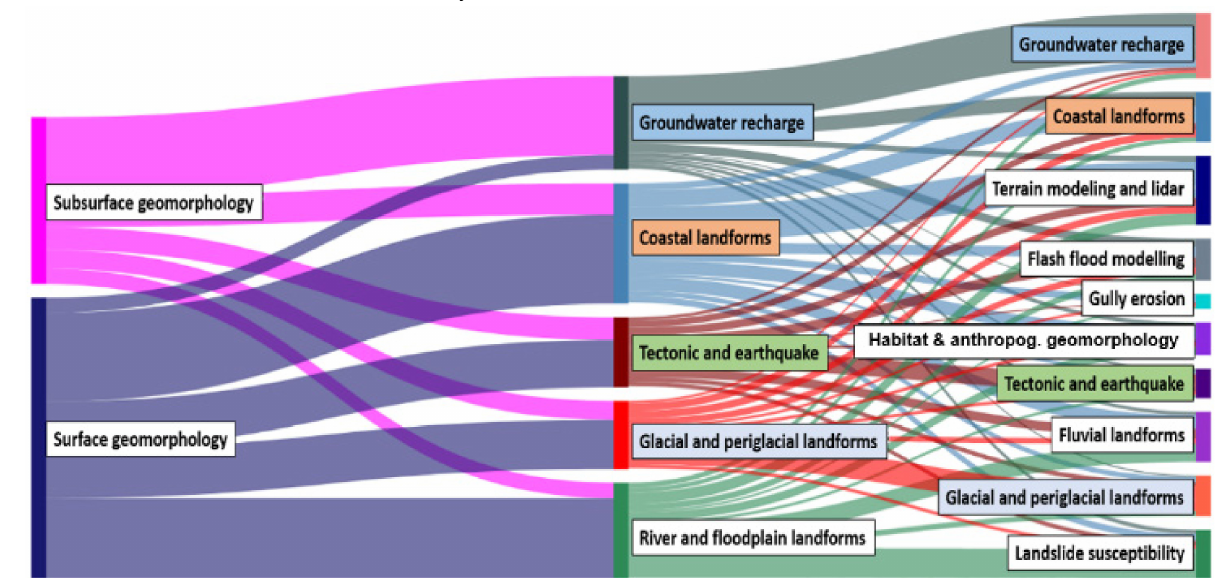
Figure 2. The mapped sub-topics and the relationships among the sub-topics of the research articles found using the search terms “geomorphology” and “remote sensing”. Two (left), five (center), and ten (right) topics were identified at the different levels, with shrinking proportion, respectively. The height of the topic bars corresponds to the topic proportion in the collection of articles. The bands’ width is proportional to the number of documents affiliated with the inter-related topics. Colors are only meant to distinguish between